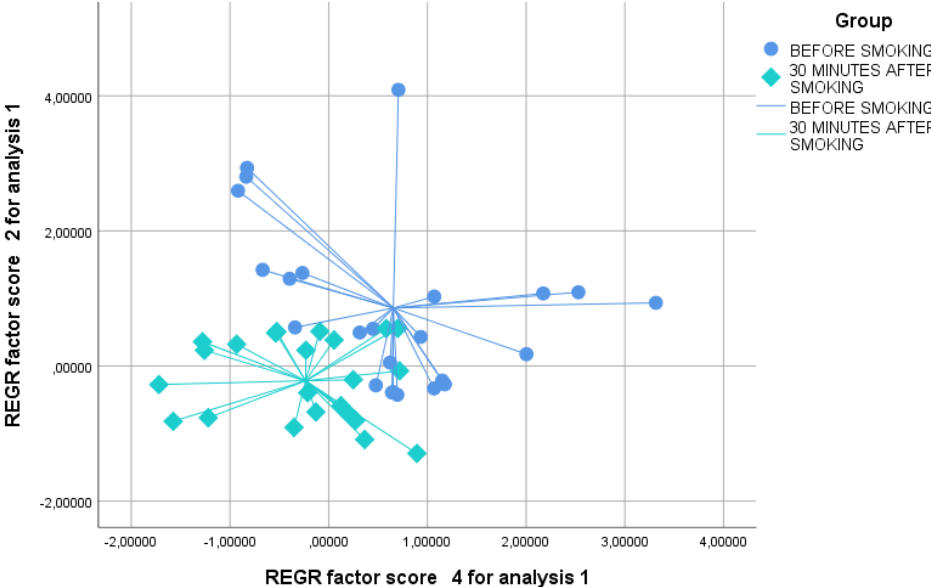
Figure 2. Two-dimensional PCA plot showing the discrimination of breathprints before smoking (blue circles) and 5 min after smoking (red squares). REGR = regression.